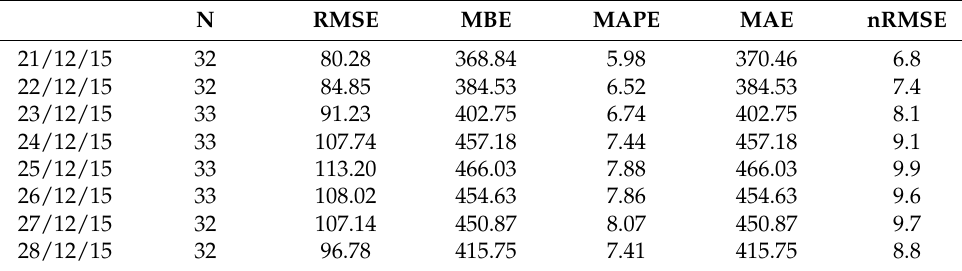
Figure 9. Comparison between real power output and simulated values for December 2015. Table 9. Statistical metrics of inv4 PVS1 during December 2014, following the winter solstice. N RMSE MBE MAPE